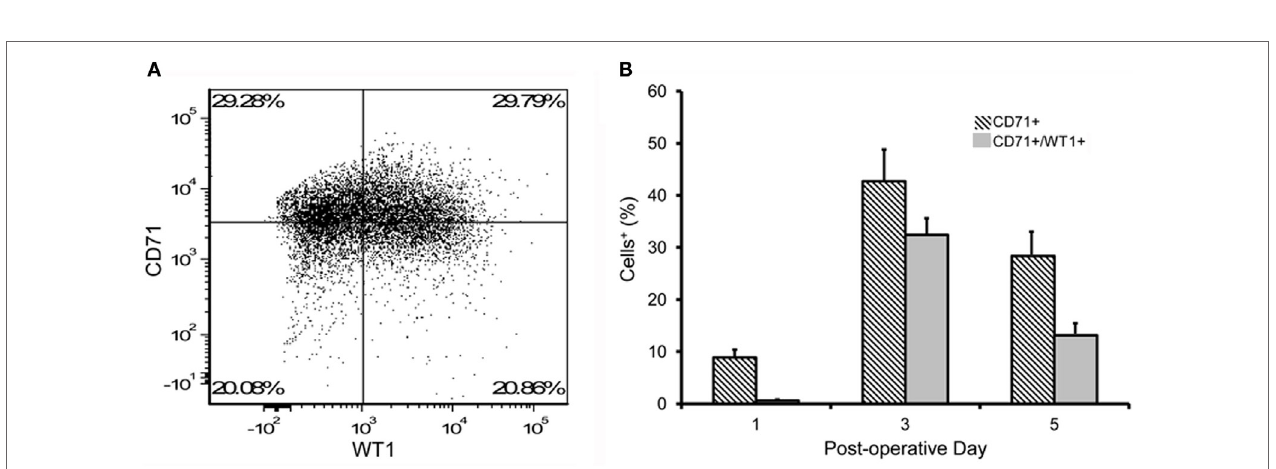
FigUre 6 | Flow cytometry of pleural fluid CD45 − cells. (a) Representative dual parameter histograms of CD45 − cells on postoperative day 3 demonstrated 70% of cells were positive for CD71 and/or WT1; 35% of cells were positive for both CD71 and WT1. (B) Consistent with single parameter staining, the double parameter flow cytometry profiles demonstrated a peak concentration of presumed mesothelial cells on postoperative day 3. N = 21 patients. Error bars reflect ± 1